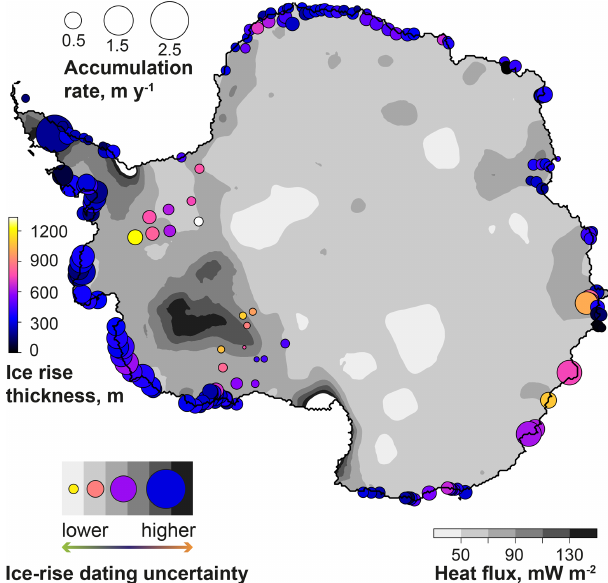
Figure 8. Antarctic ice rises and their suitability for dating of the potential Holocene ice-sheet regrounding. Circles correspond to the locations of ice rises from an Antarctic-wide inventory presented in Matsuoka et al. (2015). Sizes of the circles correspond to the mean present-day accumulation rates at their locations. Basemap shows distribution of basal geothermal heat flux presented in Martos et al. (2017). Areas where ice rise inverse dating techniques could be best applied are characterised by low heat flux, high ice thickness and low accumulation